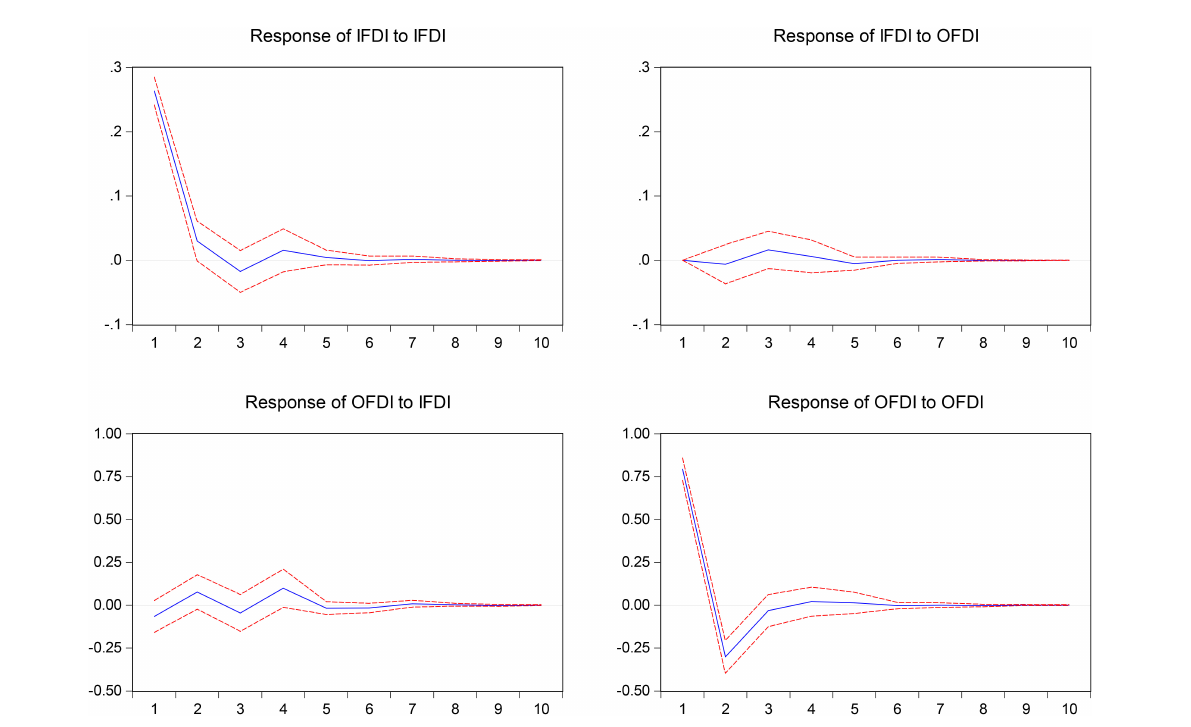
FIGURE2 Pulse response function diagram. The blue line is the impulse response estimates for a horizon of up t time, and the two red lines are the one-standard error confidence